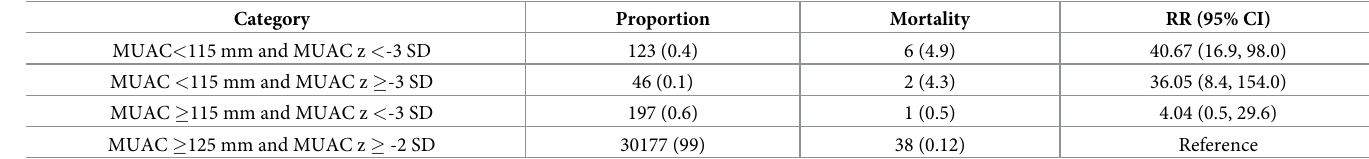
Table 4. Mortality and risk of mortality in children aged 6–59 months of age by combined categories of MUAC and MUAC z-score. Category Proportion Mortality RR (95% CI) MUAC < 115 mm and MUAC z < -3 SD 123 (0.4) 6 (4.9) 40.67 (16.9, 98.0) MUAC < 115 mm and MUAC z (cid:21) -3